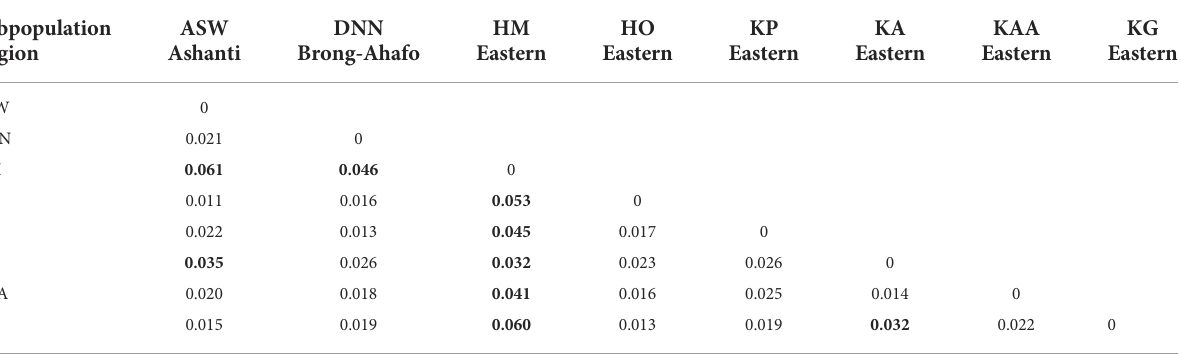
TABLE 4 Pairwise F ST values between eight Cryptolepis sanguinolenta populations.